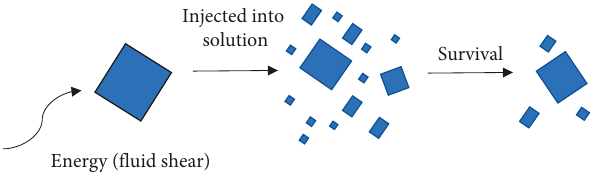
Figure 1: The contact nucleation in